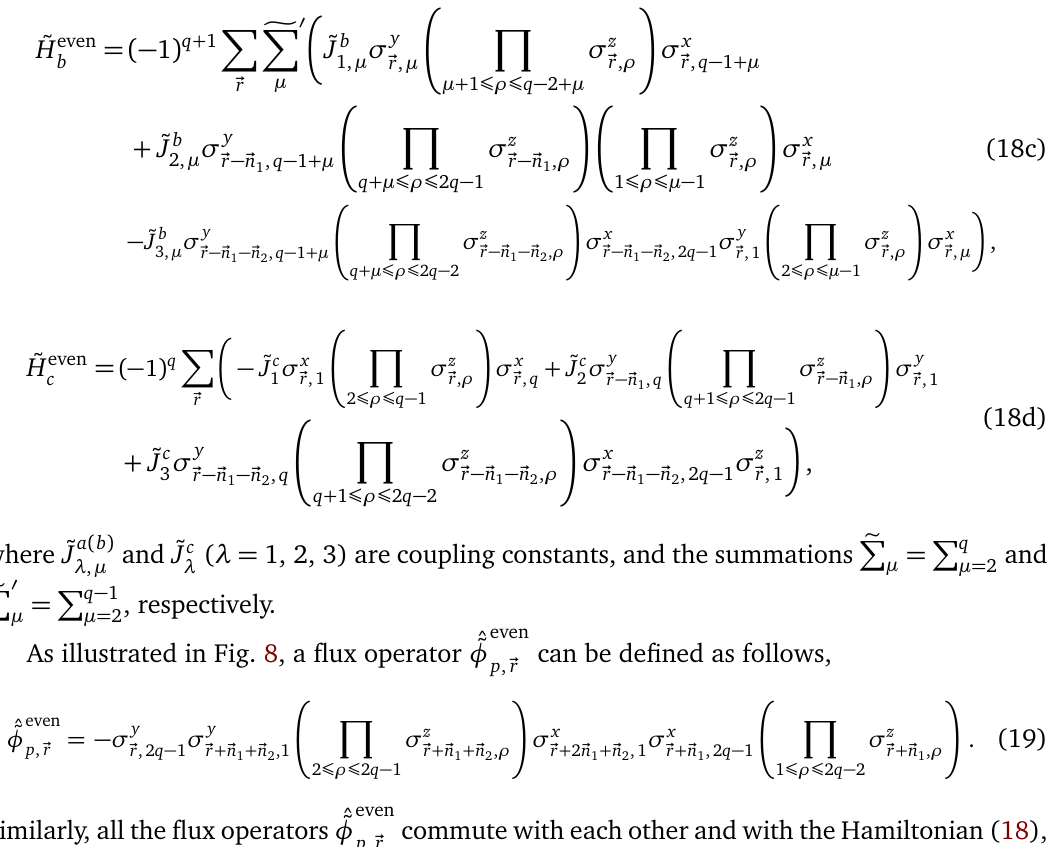
Figure 7: (a) A 2D lattice on which the Hamiltonian (18) is defined. Each unit cell consists of 2 q − 1 sites and dashed lines represent the abbreviated 2 q − 3 sites between the sites µ = 1 and µ = 2 q − 1. Each unit cell is labeled by ⃗ r = l ∈ (cid:78) ⃗ n and ⃗ n are the primitive vectors for the lattice. (b), (c) and (d) + ), where 1 2 denotes the terms in ˜ H even , ˜ H even and ˜ H even , respectively. Blue stars represent the a c b product of σ z ’s on corresponding abbreviated